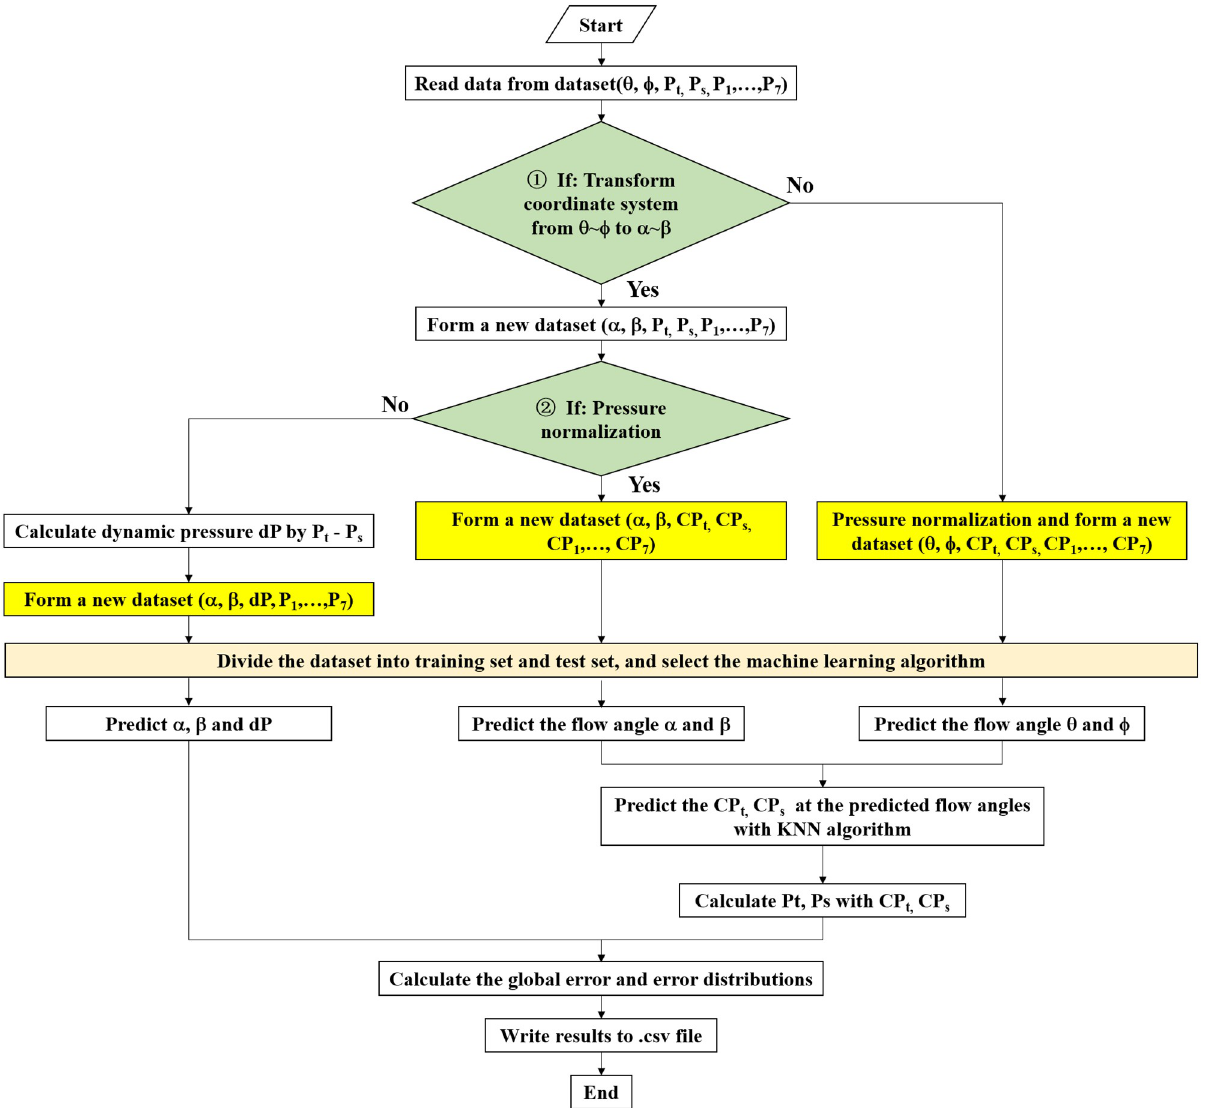
Fig 5. Flow chart of probe calibration with three different feature extraction